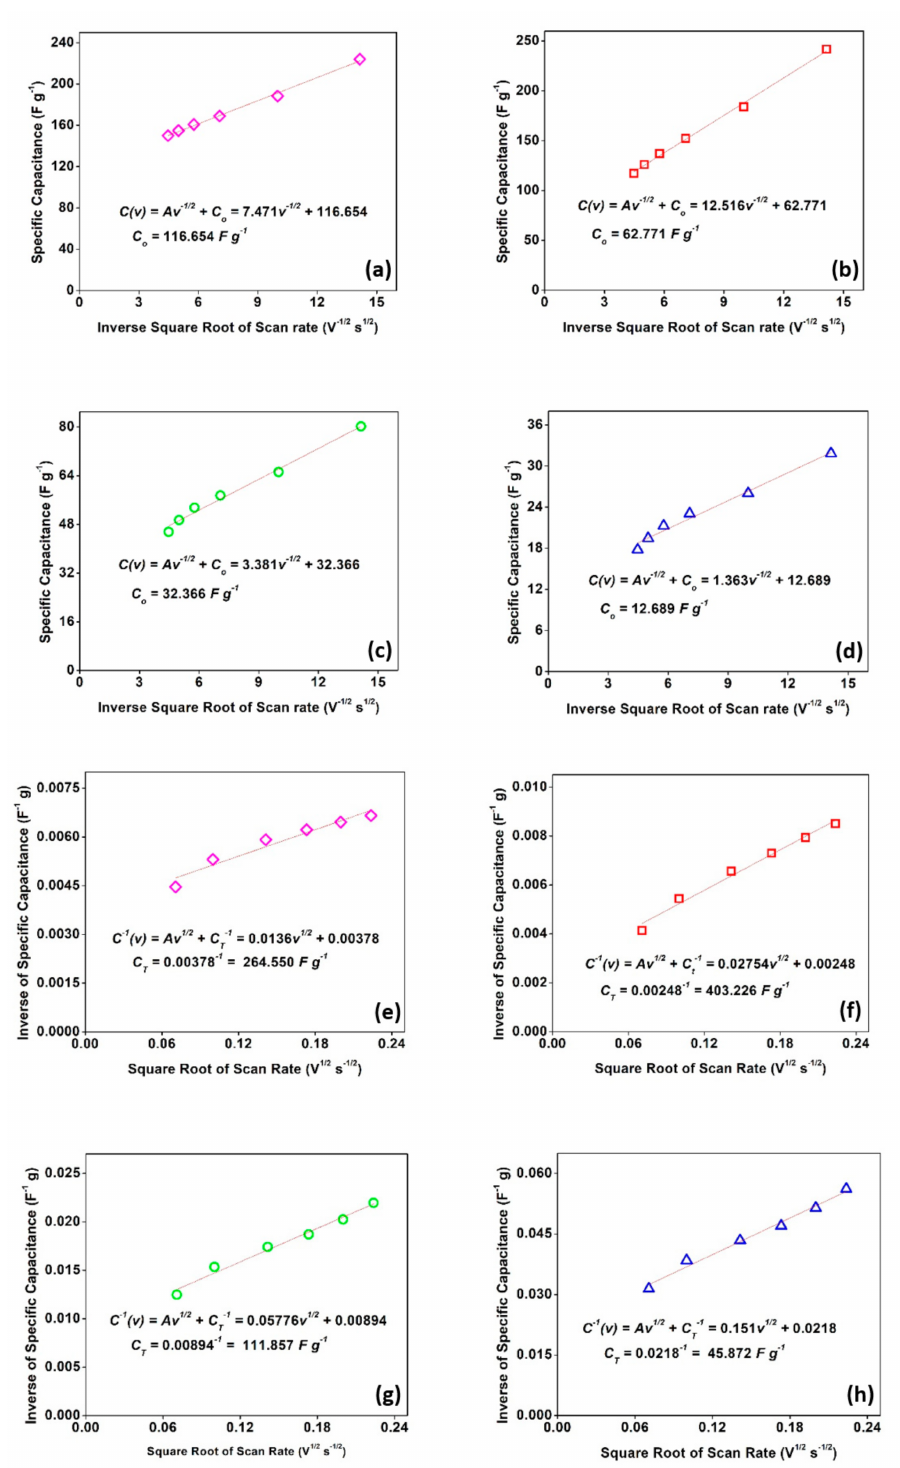
Figure 8. Trasatti method for C o determination of ( a ) CN-R, ( b ) CN-300, ( c ) CN-400, and ( d ) CN-500; and C T determination of ( e ) CN-R, ( f ) CN-300, ( g ) CN-400, and ( h )